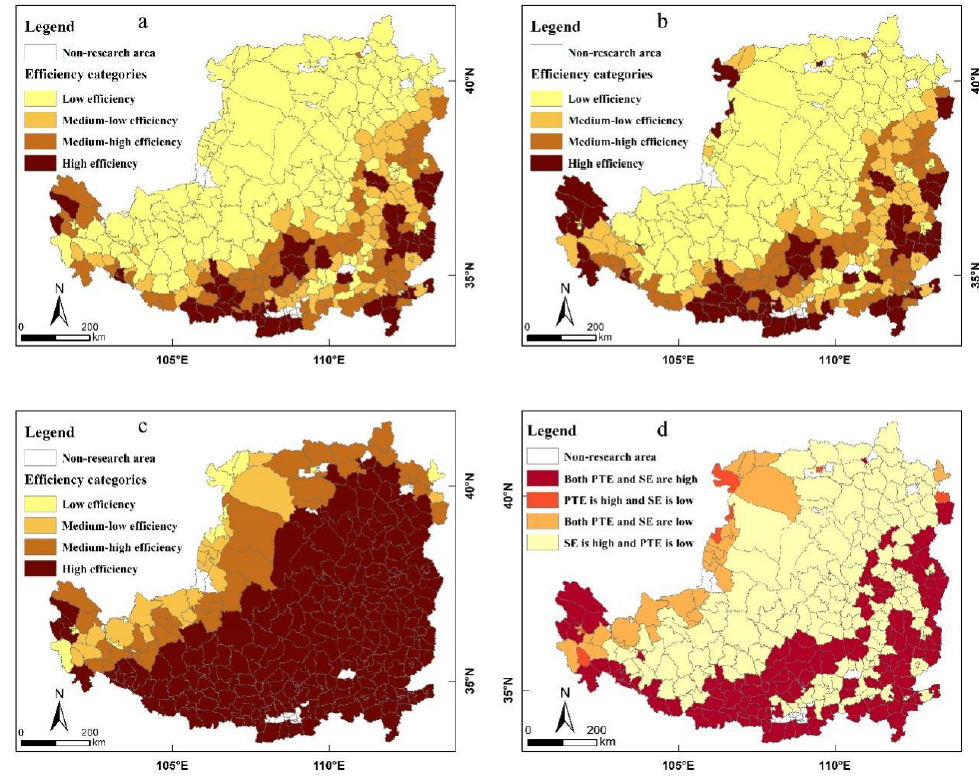
Figure 5. The average value of ( a ) TE, ( b ) PTE, and ( c ) SE for 314 counties from 2002 to 2015. ( d ) The contribution of PTE and SE to TE for 314 counties from 2002 to 2015.